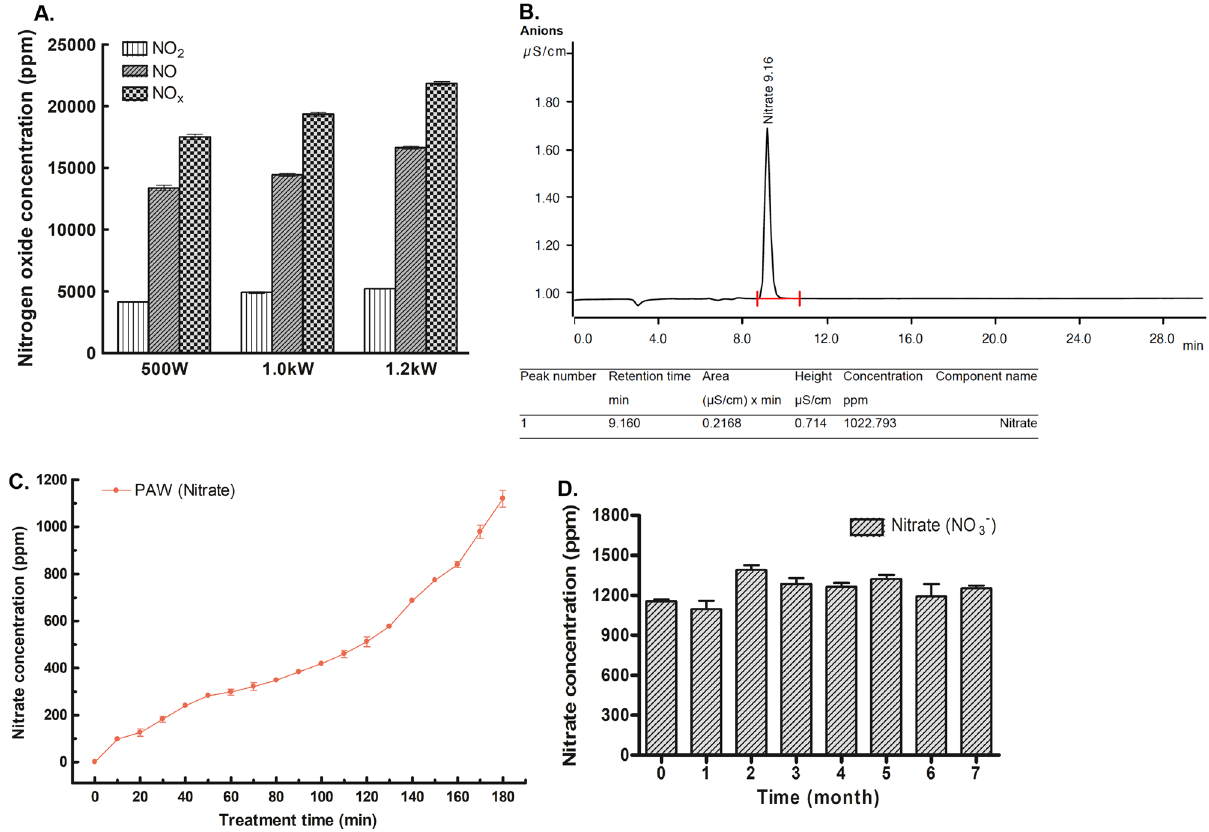
Figure 2. Measurement of nitrogen oxide produced by microwave plasma and nitrate concentrations in plasma-activated water (PAW). ( A ) The concentrations of total nitrogen oxide (NOx), nitric oxide (NO) and nitric dioxide (NO 2 ) were assessed at microwave powers of 500 W, 1.0 kW, and 1.2 kW. As the power increased, species generation increased. ( B ) Only nitrate anion (NO 3 − ) was detected by ion chromatography in PAW. ( C